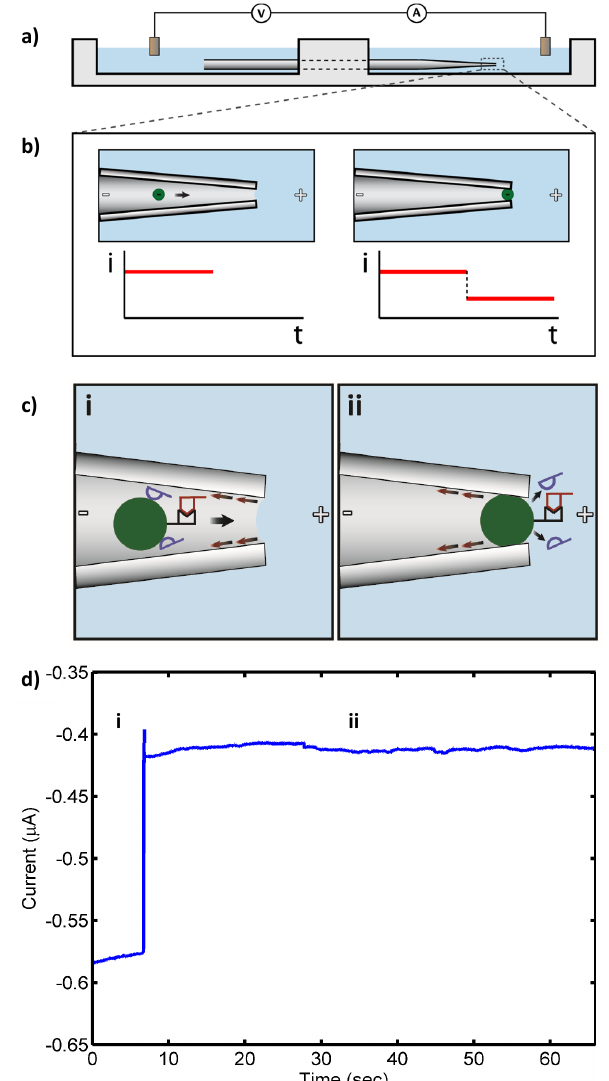
Figure 1. ( a ) Apparatus schematic. A micropipette drawn to a 2 µm diameter bridges two chambers filled with electrolyte. Negatively charged 3 µm diameter beads placed in the micropipette are electrophoretically drawn to the narrow end of the micropipette by an electric field applied by electrodes in each of the chambers. ( b ) When a bead reaches the narrow end of the micropipette, it blocks the current, which is measured by the electrodes. ( c ) Schematic of target 16S rRNA (10 pM, red) hybridized to PNA-bead conjugates in the drawn micropipette under applied electric field in the presence of nonspecifically bound, background RNA (blue): (i) open pore state as bead with bound RNA approaches the micropipette tip (“pore”); and (ii) blockade of the pore by the PNA-bead conjugate with bound RNA (blocked pore state). Nonspecifically bound RNA (blue) detaches from the bead in the strong electric field at the micropipette tip, while the specifically bound RNA remains, leading to a persistent blocked pore state. ( d ) Measured ionic current through the pore: (i) open pore current; and (ii) current blockade by PNA-bead conjugates with bound RNA.